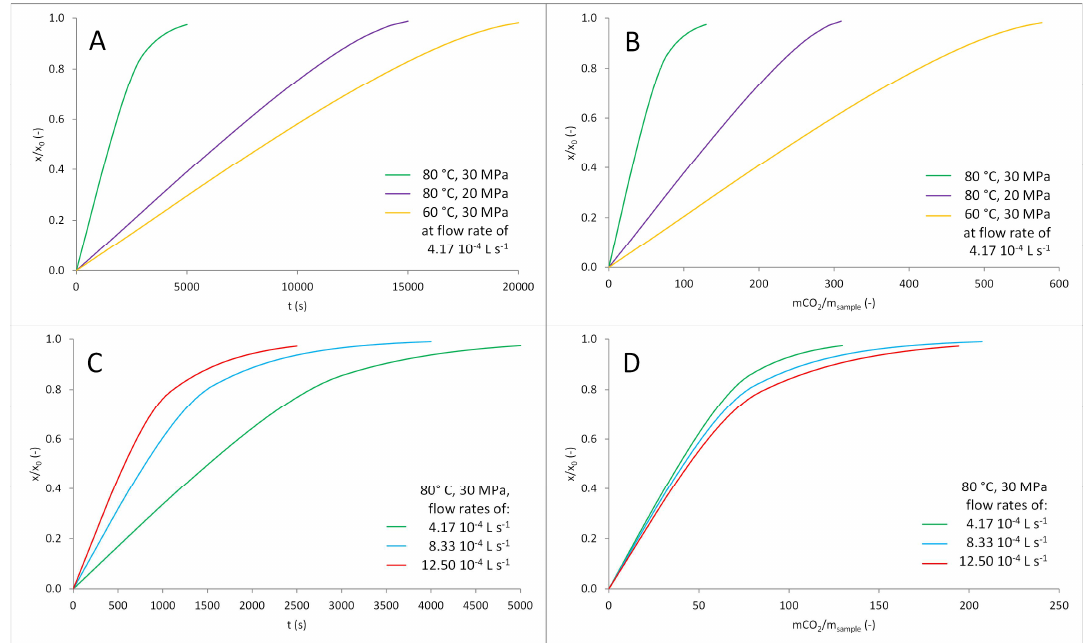
Figure 5. The extraction curves for the isolation of ursolic acid. The impact of temperature and pressure as a function of time ( A ) and mass of carbon dioxide per mass of sample ( B ). The impact of flow rate as a function of time ( C ) and mass of carbon dioxide per mass of sample ( D